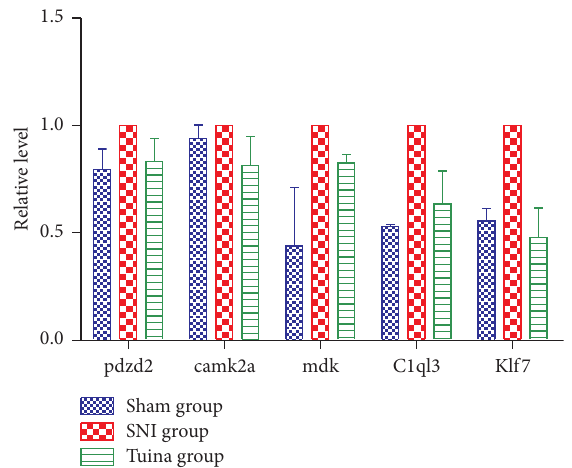
Figure 4: RT-PCR expression results. The abscissa is the gene name, and the ordinate is the relative